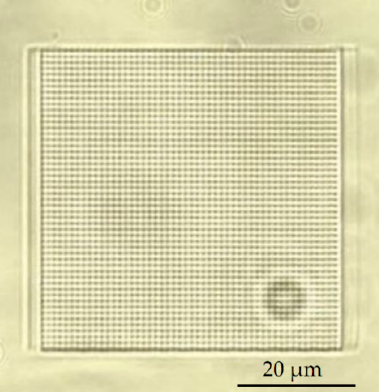
Figure 6. Isolated example of 3DLL-made square-grid membrane.